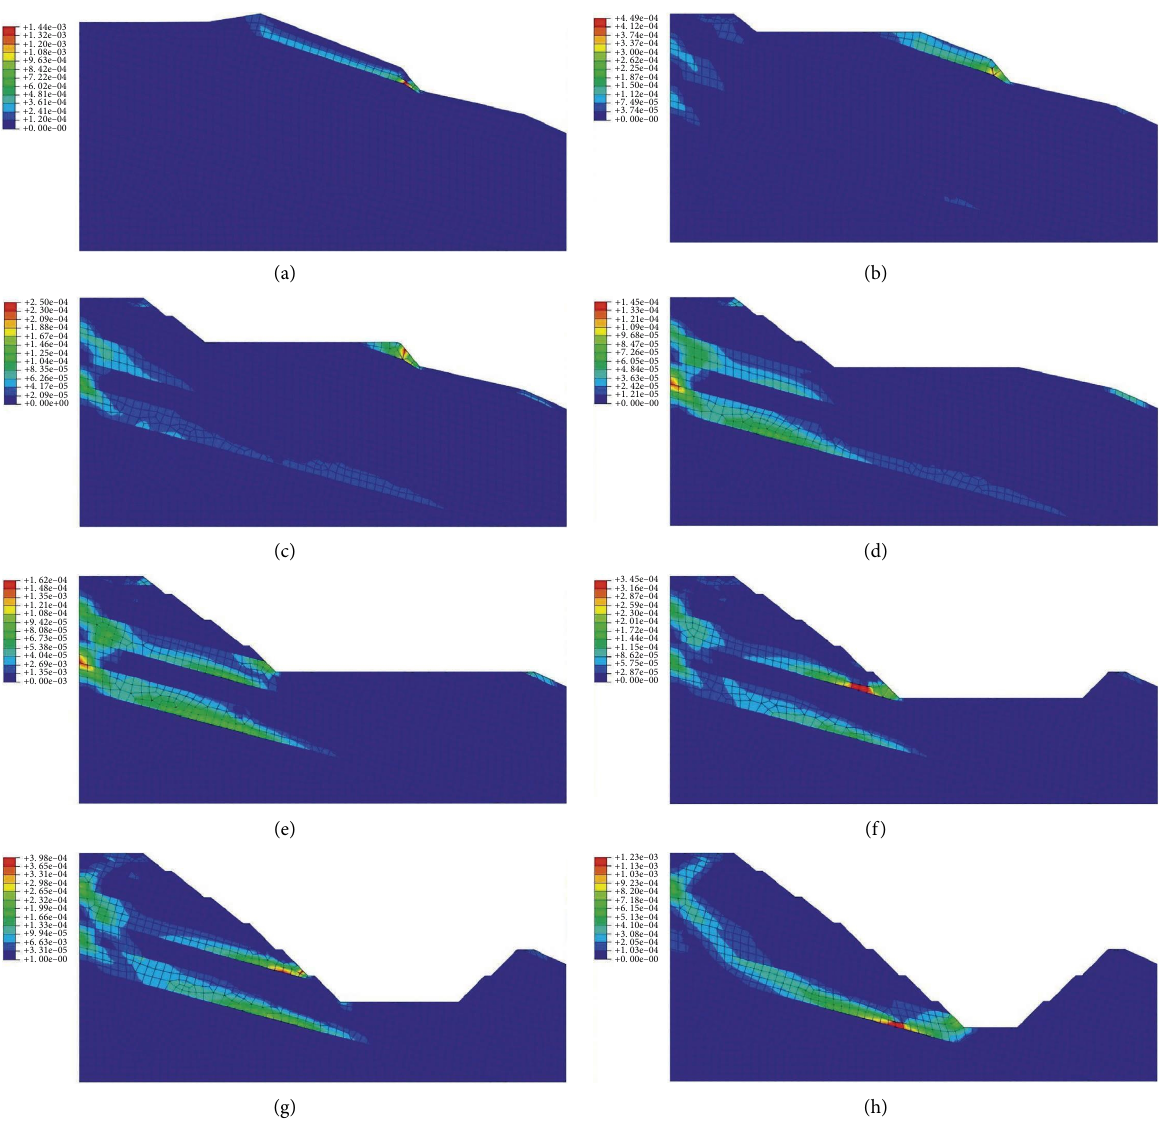
Figure 4: Maximum strain distribution nephogram: (a) before excavation, (b) seventh stage excavation, (c) sixth stage excavation, (d) ffth stage excavation, (e) fourth stage excavation, (f) third stage excavation, (g) second stage excavation, and (h) frst stage